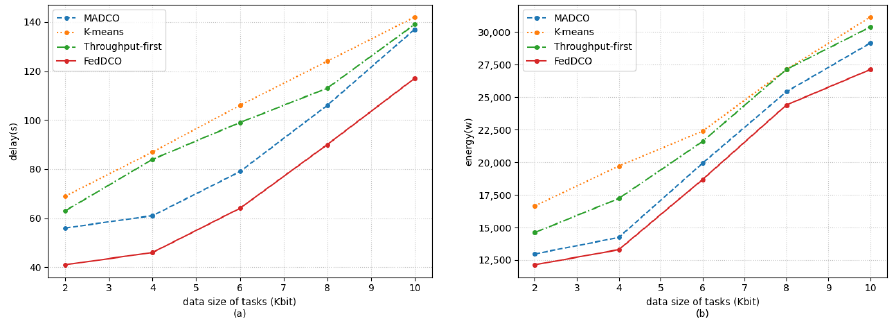
Figure 5. Comparison of network performance metrics at different data sizes of the tasks. ( a ) Task processing delay. ( b ) Energy